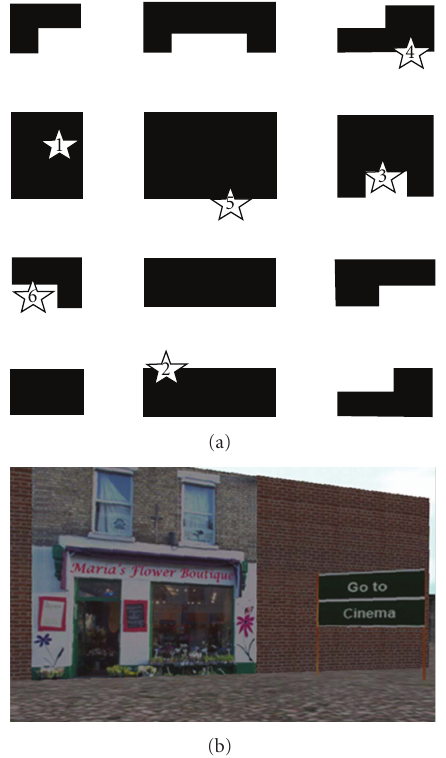
Figure 1: Cognitive Map Test. (a) Schematic map of the city. Num- bers indicate the location of the landmarks (1: cinema; 2: flower shop; 3: hotel; 4: bar; 5: pharmacy; 6: restaurant). (b) View of the participants’ starting position in one trial of the retrieval